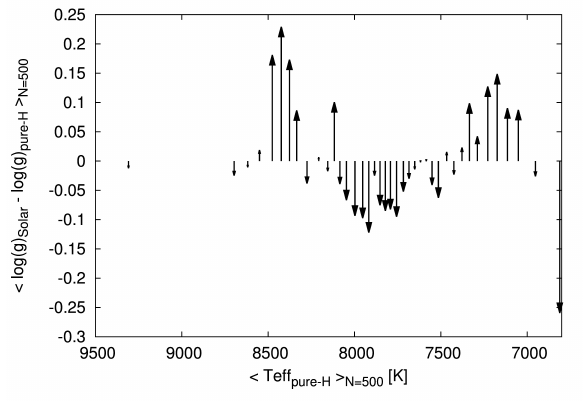
Figure 4. Change in log g when metals were added to the models as a function of the effective temperature of the pure-H models. The T eff and the change in log g were averaged over 500 objects, sorted by T eff . The apparent puzzling behaviour is a consequence of the systematic effect found for as a function of log g pure-H , which implies a correlation also in T eff , depending on how each range of log g is sampled in each bin of T eff , as discussed in the